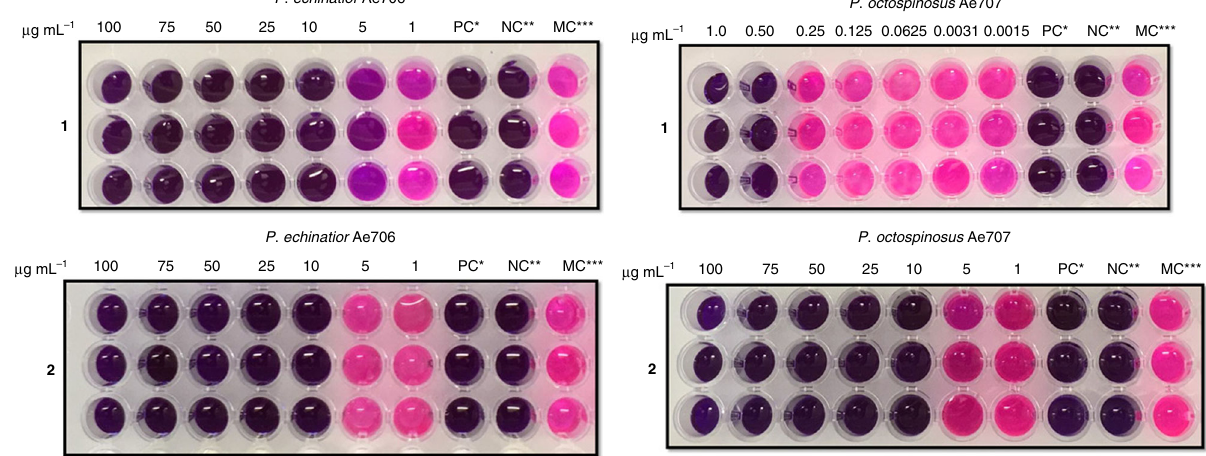
Fig. 6 Growth of Pseudonocardia mutualists is inhibited by Escovopsis small molecule virulence factors. Microplate assay of 1 (top) and 2 (bottom) against Pseudonocardia strains Ae706 and Ae707. *PC is the positive control (50 µ g ml − 1 cipro fl oxacin). **NC is the negative control (no inoculation). ***MC, the bacteria grown in LB with 5% of methanol. The pink color indicates viable bacterial